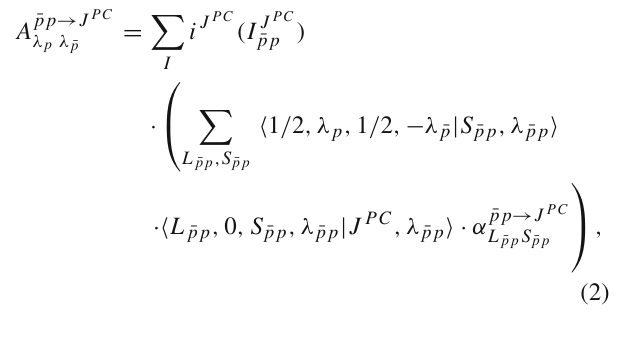
Fig. 6 Graphical representation of the most important kinematic vari- ables for the production ( a ) and decay ( b ) reference frames. As an example, a scenario corresponding to the ¯ pp → K + K − π 0 channel was chosen. The z -axis in a is defined by the flight direction of the antiproton, while the directions of the x − and y -axes are arbitrary and only defined in the laboratory frame by convention ( y -axis pointing up inverticaldirection).The ¯ pp systemthendecaysto K ∗+ K − ,withafur- ther decay of the K ∗+ into K + π 0 (black), or e.g. into f 0 π 0 with the f 0